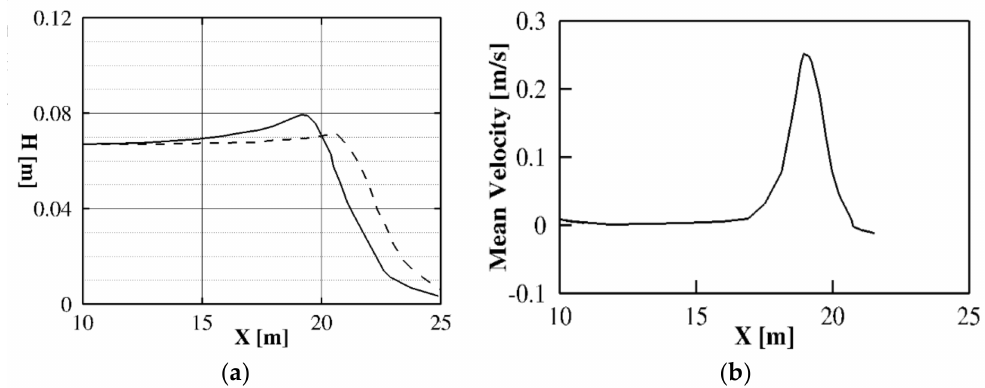
Figure 12. Case 2: ( a ) Wave height comparison between section E-E’ (solid line) and section F-F’ (dashed line); ( b ) Time-averaged cross-shore (over 120 wave periods) velocity component along the section in the gap between the barriers (section